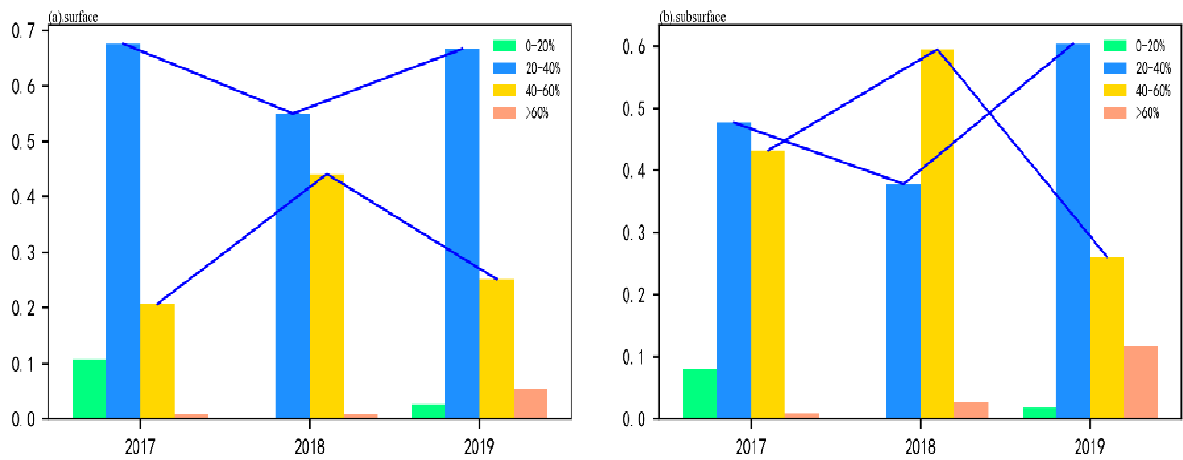
Figure 10. Changes of the Percentage of Drought Weeks (PDW) at the surface ( a ) and subsurface ( b ) in four southern provinces of China from 2017 to